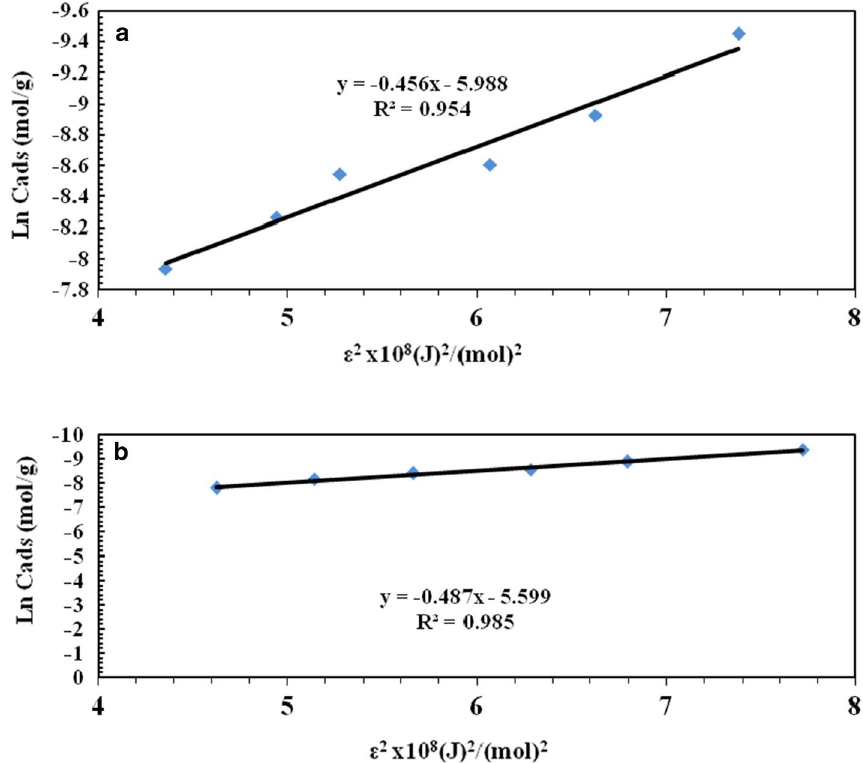
Fig. 11 a , b DKR isotherm models for chromium ions removal using a ACP-Znand b ACP-Zn-Fe at pH 2.0—2.5 and 25 ± 0.2 °